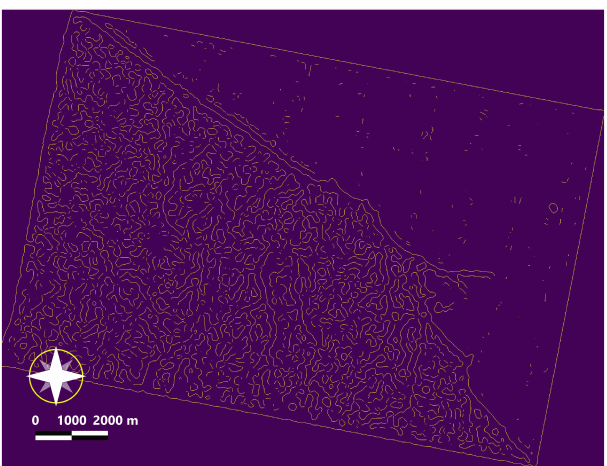
Figure 4. Canny algorithms applied on the pre-processed Sentinel-1 image acquired on 31 December 2019.